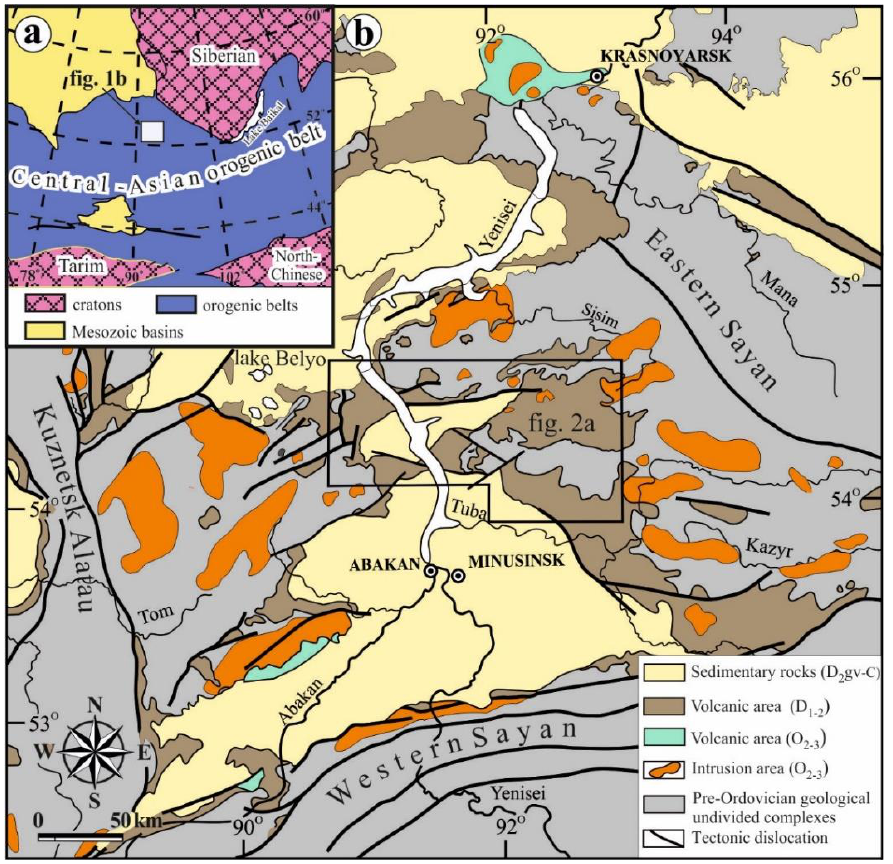
Figure 1. ( a ) Location of the Minusinsk Trough in the Central Asian orogenic belt. ( b ) Early Middle Paleozoic magmatic areas of the Minusinsk Trough; data source from [47,48].